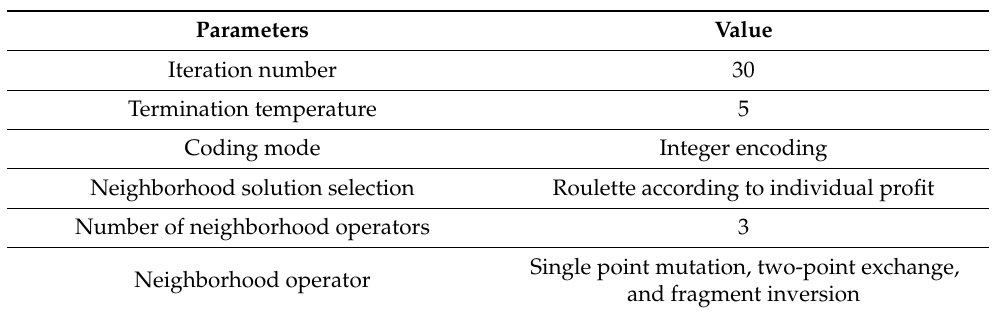
Table 10. The parameters in